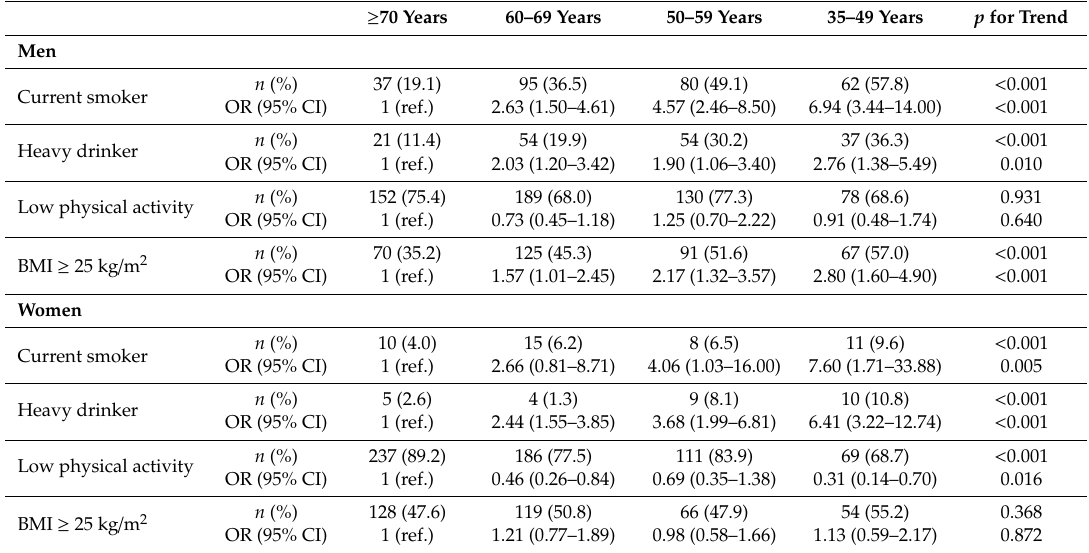
Table 2. Lifestyle factors and obesity according to age group among patients with